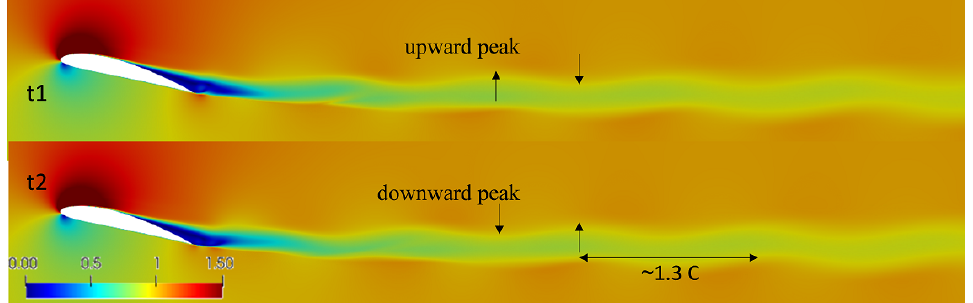
Figure 11. CFD instantaneous wake at two selected times: t1 and t2 with interval of one period. Airfoil is at AOA = 14 ◦ , and the flow field is contoured with the normalized streamwise velocity.